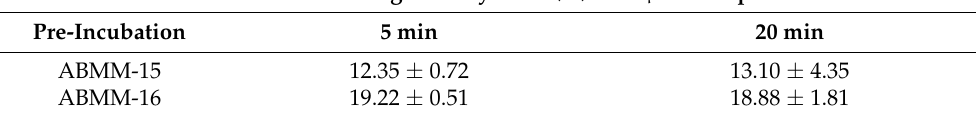
Table 2. Results of the inhibition screening after 5 and 20 min of pre-incubation for ALDH1A3 at 250 µ M